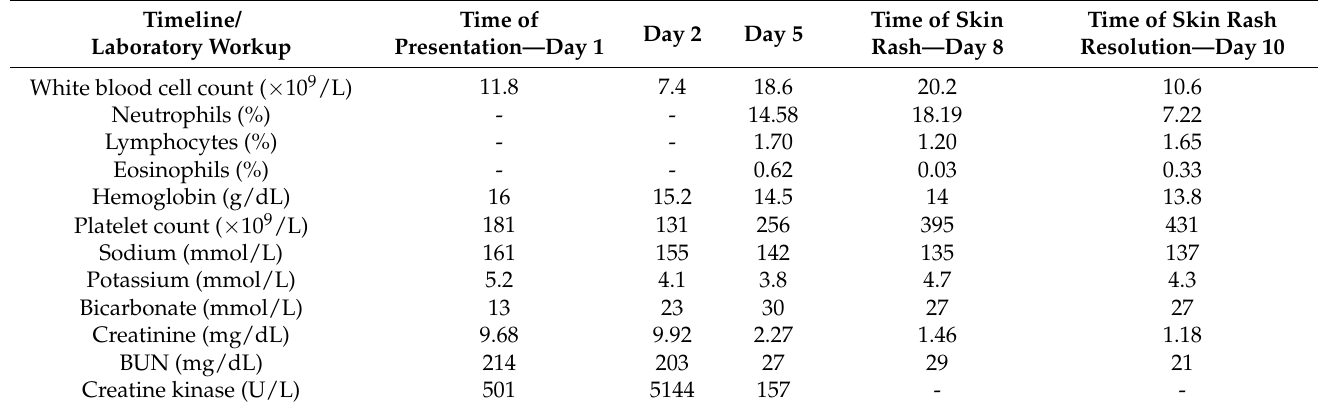
Table 1. Summary of the relevant laboratory blood workup from the time of patient admission to the time of skin rash